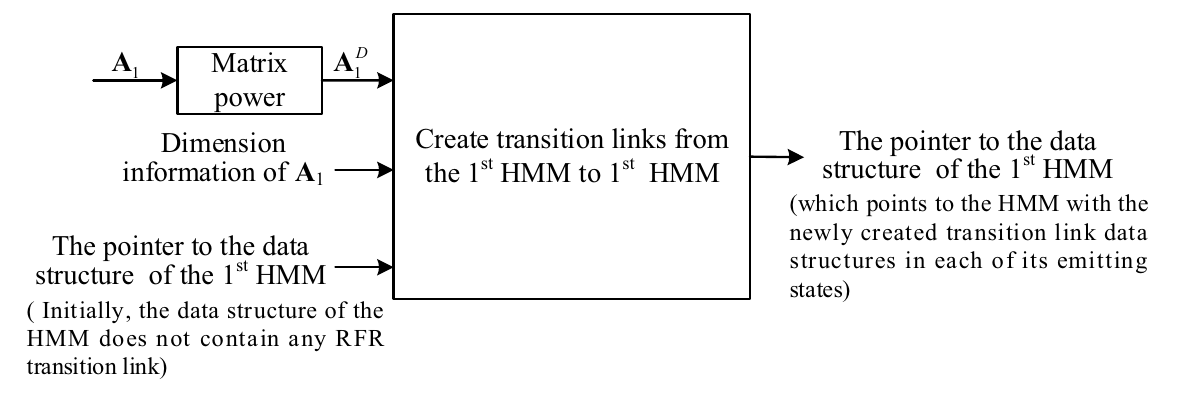
Fig 6. The creation of model internal transition links for frame rate reduction factor D